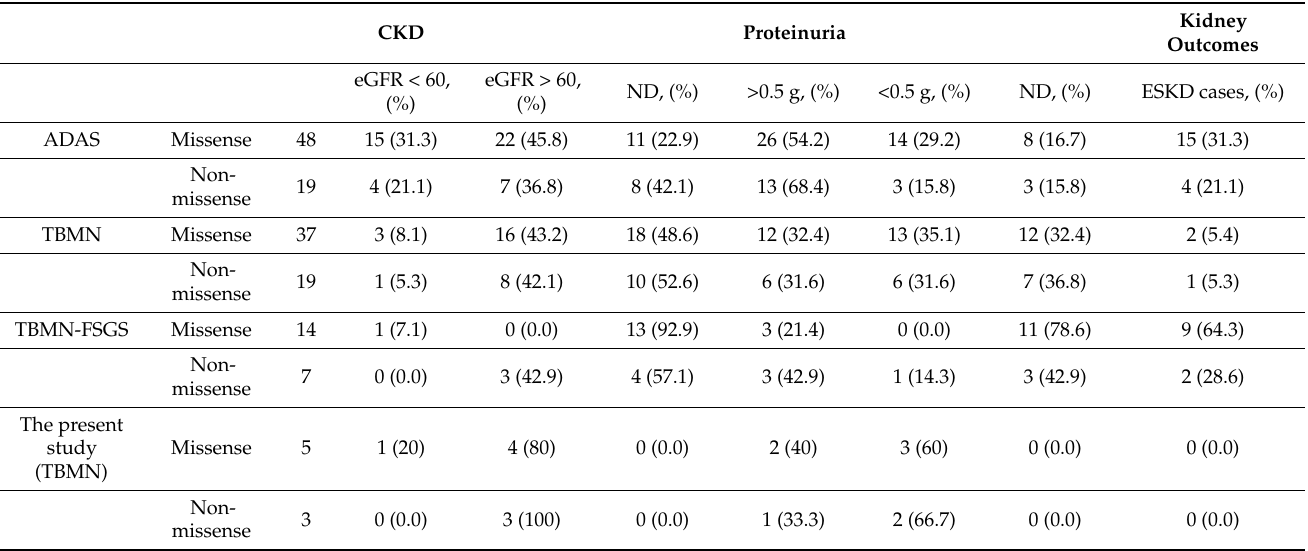
Table 3. Summary of patients with heterozygous COL4A3/COL4A4 mutations who received a kidney